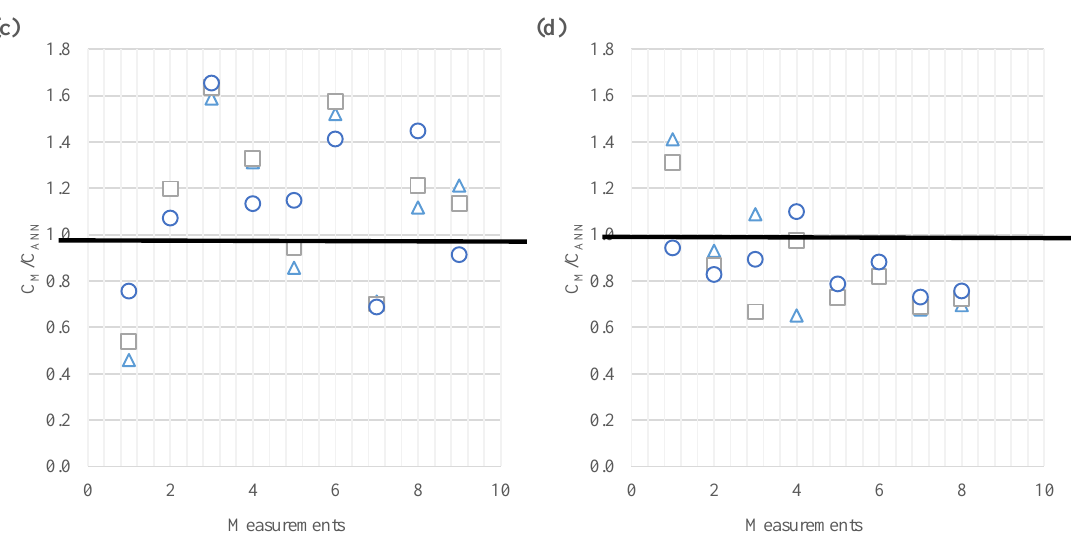
Figure 3. Comparison of measured and calculated concentrations: ( a ) bulk cargo ship, ( b ) chemical tanker, ( c ) trawler, ( d ) refrigerated cargo ship. For wider analysis, results by ship type are presented in Figure 4 for four ship types. RoRo, R 2 = 0.91 – 0.94 for general cargo, R 2 = 0.71 – 0.92 for bulk, and R 2 = 0.75 – 0.91 for tugs.